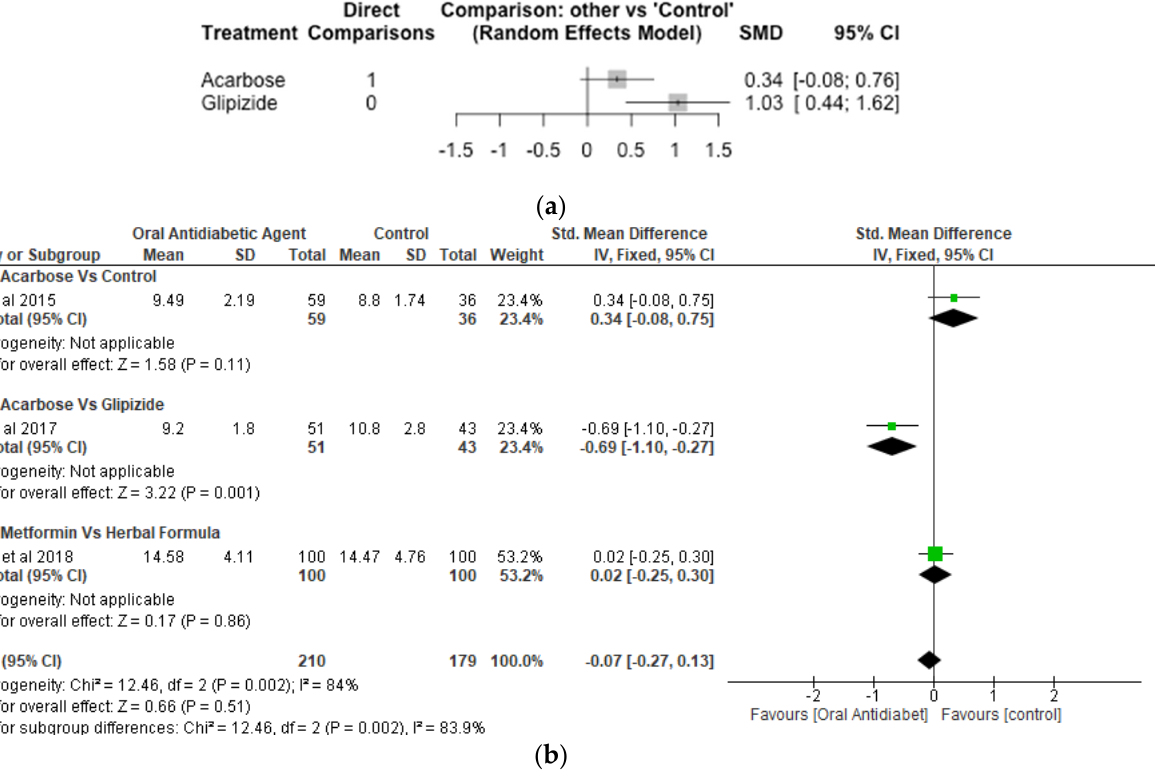
Figure 8. Network Meta-analysis ( a ) and Meta-analysis ( b ) of the effect of treatments versus control on Postprandial Blood Glucose [40,45,46].